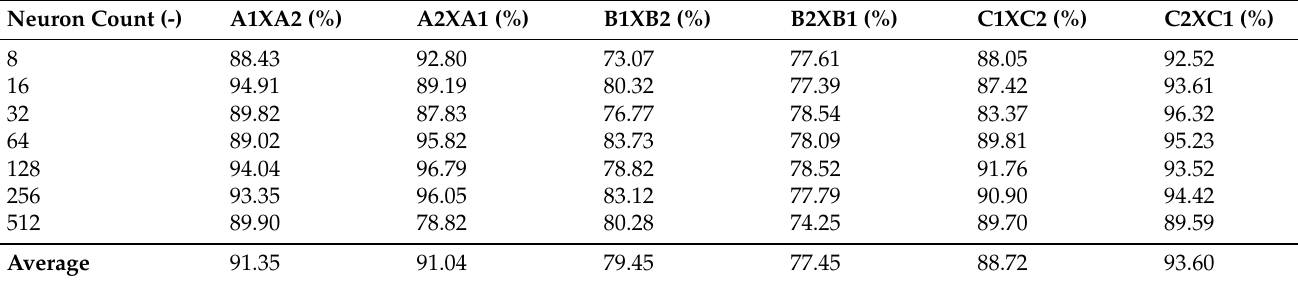
Table 6. Scoring accuracy of the developed